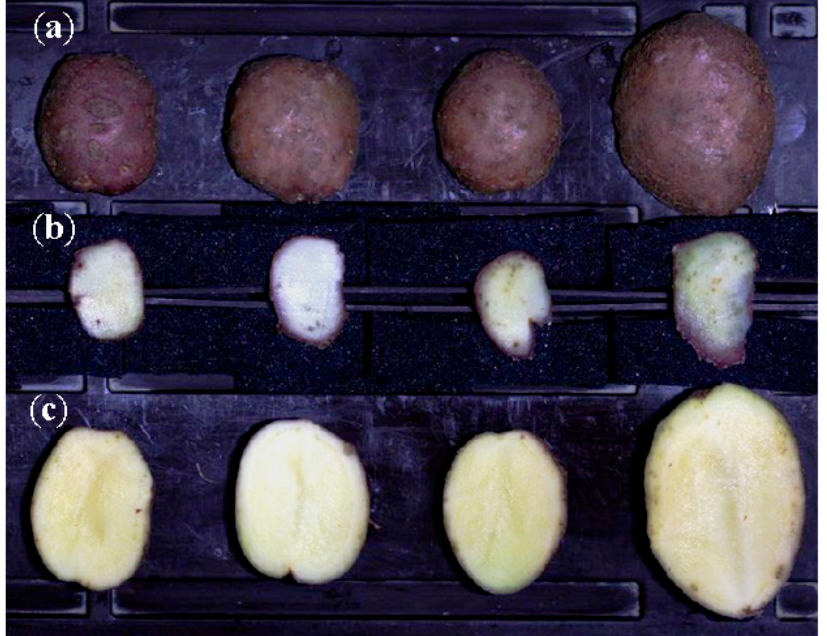
Figure 2. Potato tubers cv. Desiree highly infested with Meloidogyne luci prepared for remote sens- ing: ( a ) tubers cut in half, outer view; ( b ) secondary peels; ( c ) tubers cut in half, inner view.